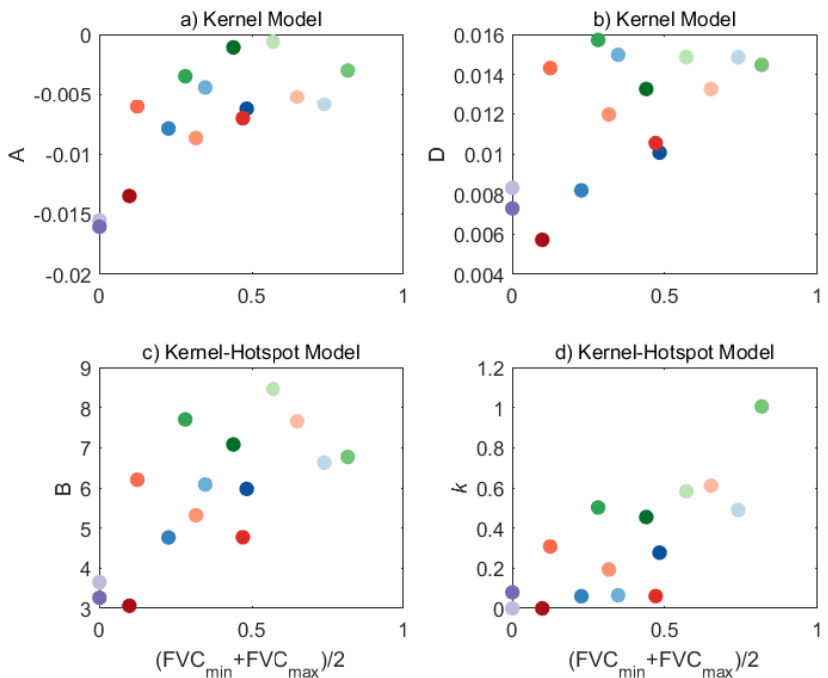
Figure 4. Parameters of the Kernel ( a , b ) and Kernel-Hotspot ( c , d ) models as function of the average FVC of the cluster. Colors indicate the different clusters of pixels and correspond to the color bar of Figure 1.